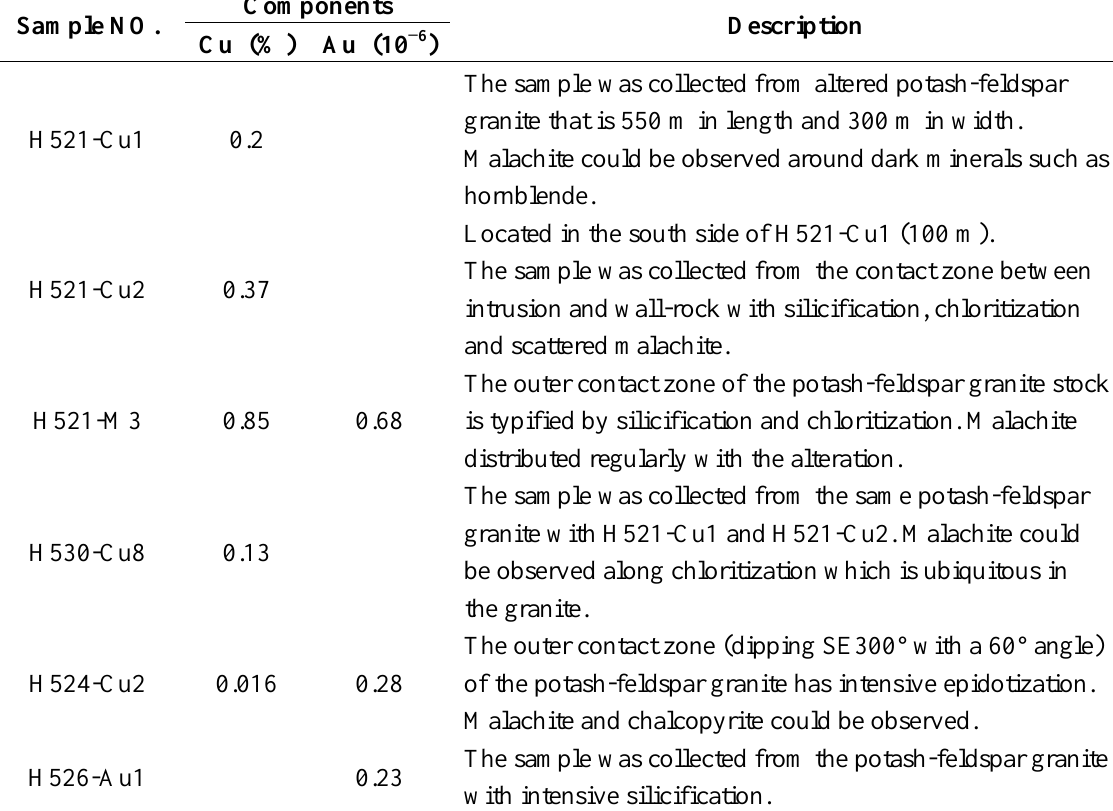
Table 4. Descriptions and laboratory analysis results of field surveyed points with hydroxyl anomalies (the points described here correspond to those highlighted in Figure 6). Sample